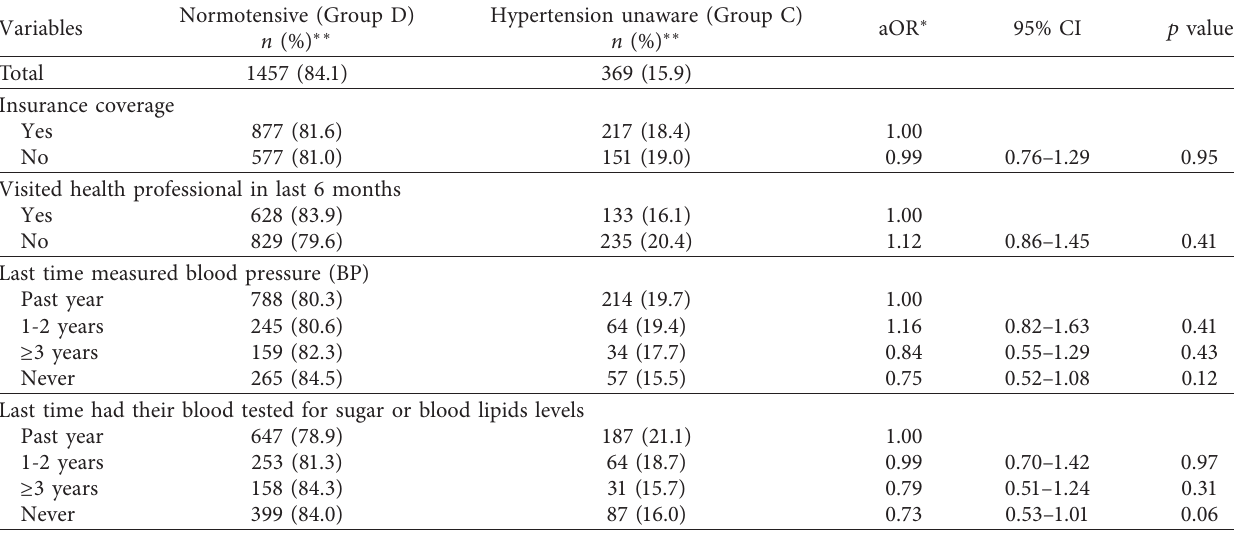
Figure 1: Prevalence of hypertension and hypertension unawareness in the total sample, and by age and gender, NNCD-RF WHO-STEPS survey, Lebanon; ∗ weighted prevalence of hypertension, calculated with the denominator being the total sample; ∗∗ weighted prevalence of hypertension unawareness, calculated with the denominator being hypertensive individuals. Table 3: Access and use of healthcare services among apparently healthy participants: comparison of hypertension unaware group with the